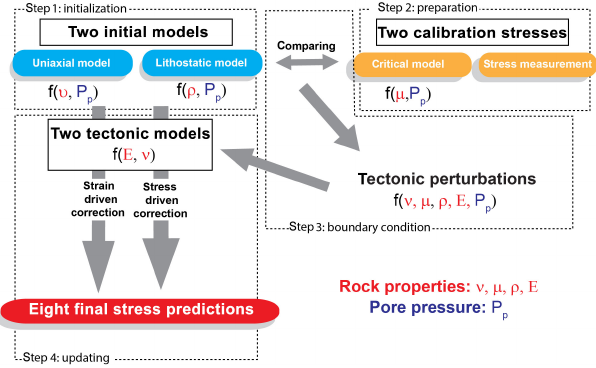
Figure 3. Flow chart detailing the different prediction strategies. See Sect. 3 for details. Rock properties used in the different models are υ Poisson’s ratio, µ friction, ρ density, and E Young’s